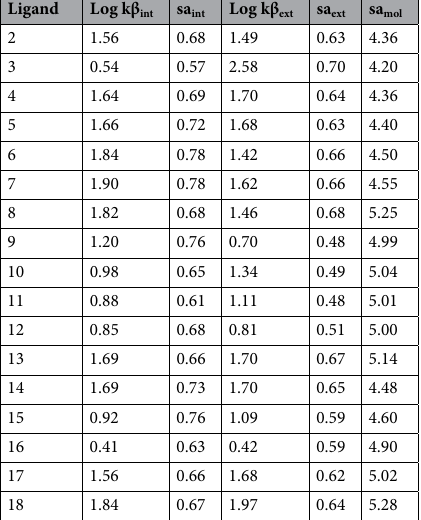
Table 5. Atomic and molecular strengths calculated using Jazzy against energy-minimised conformations of the selected inhibitors (sa int , sa ext , sa mol ) and the acceptor strengths calculated by Robb and colleagues (Log kβ int , Log kβ ext ). Internal (int) and external (ext) strengths represent those associated with the intra- and intermolecular hydrogen bonds, respectively. sa mol represents the sum of all atomic acceptor